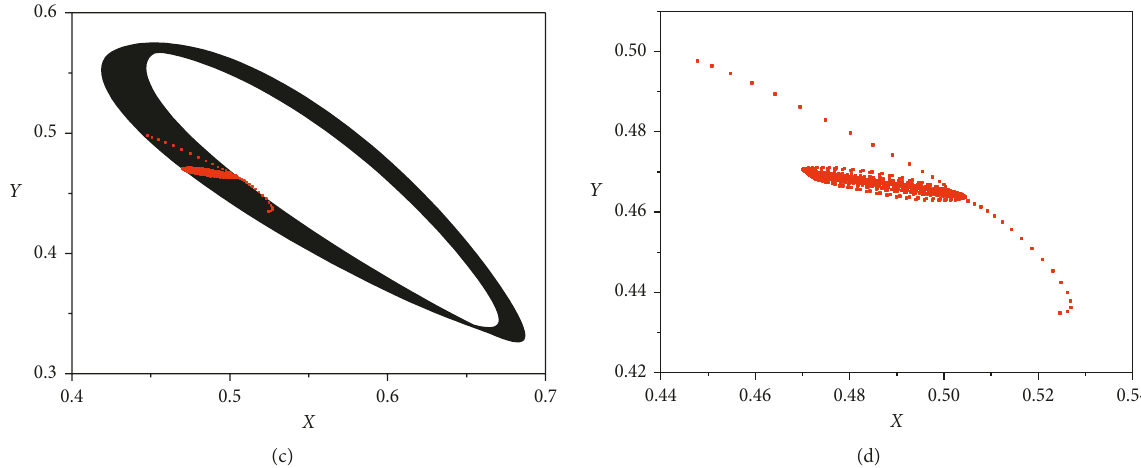
Figure 16: (a) Displacement. (b) Frequency response. (c) Rotor orbit. (d) Poincar´e map where